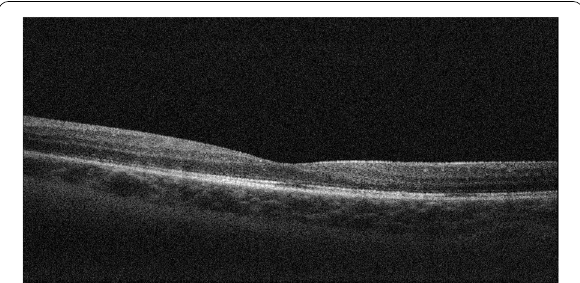
Fig. 3 Optical coherence tomography shows complete resolution of the cystoid macular edema four weeks following dexamethasone implant